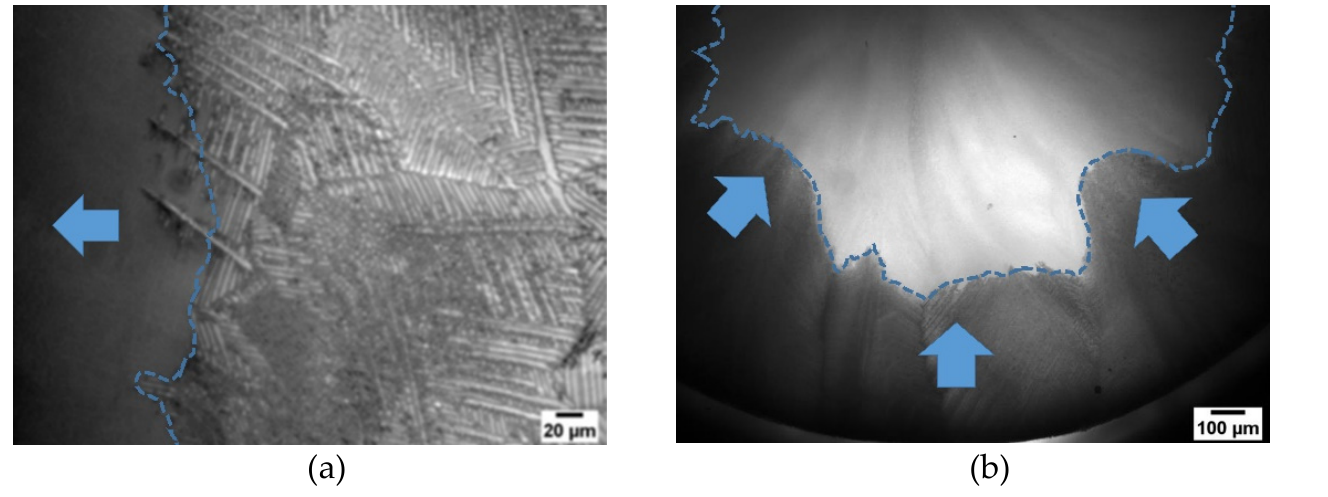
Figure 12. Images (Sucrose solution (c = 0.15 w/w with 50 K/min cooling rate)) of fissured sublima- tion fronts due to the local microstructure: ( a ) high resolution to resolve microstructure; lamella structure which is perpendicular to the drying front dries faster. ( b ) Lower resolution to resolve global sublimation front; areas which dries faster compared to others due to different microstruc- tures.